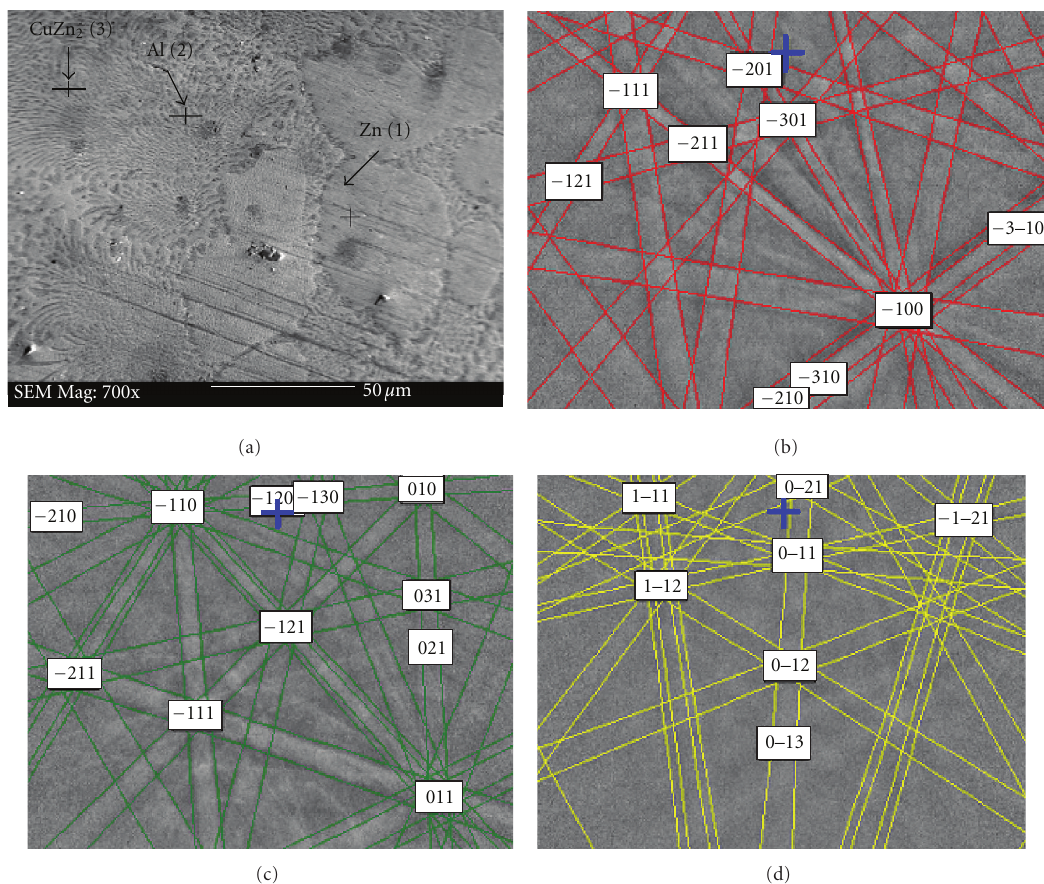
Figure 2: EBSD identification of phases. (b) solid solution of Al in Zn, (c) solid solution of Zn in Al rich or metastable Al, and (d) CuZn 4 precipitates.